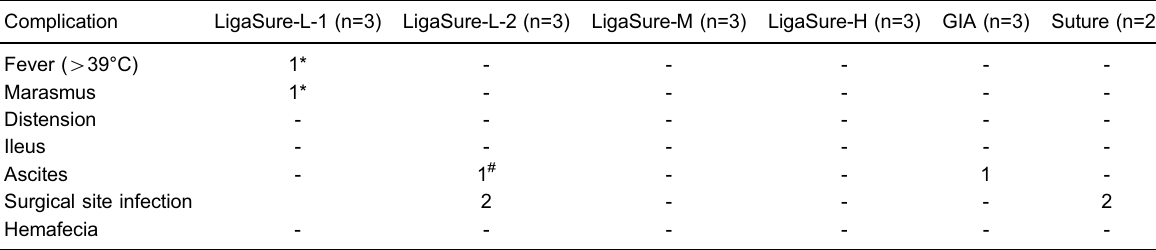
Table 1. Complications other than anastomosis leakage of surviving